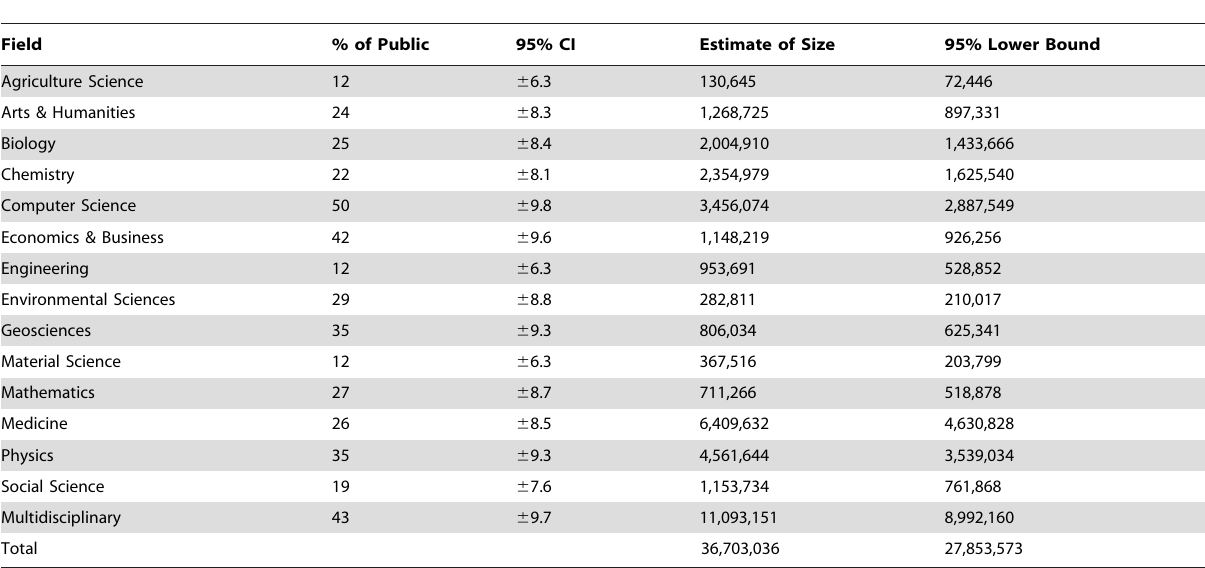
Table 2. The percentage of publicly available scholarly documents found in Google